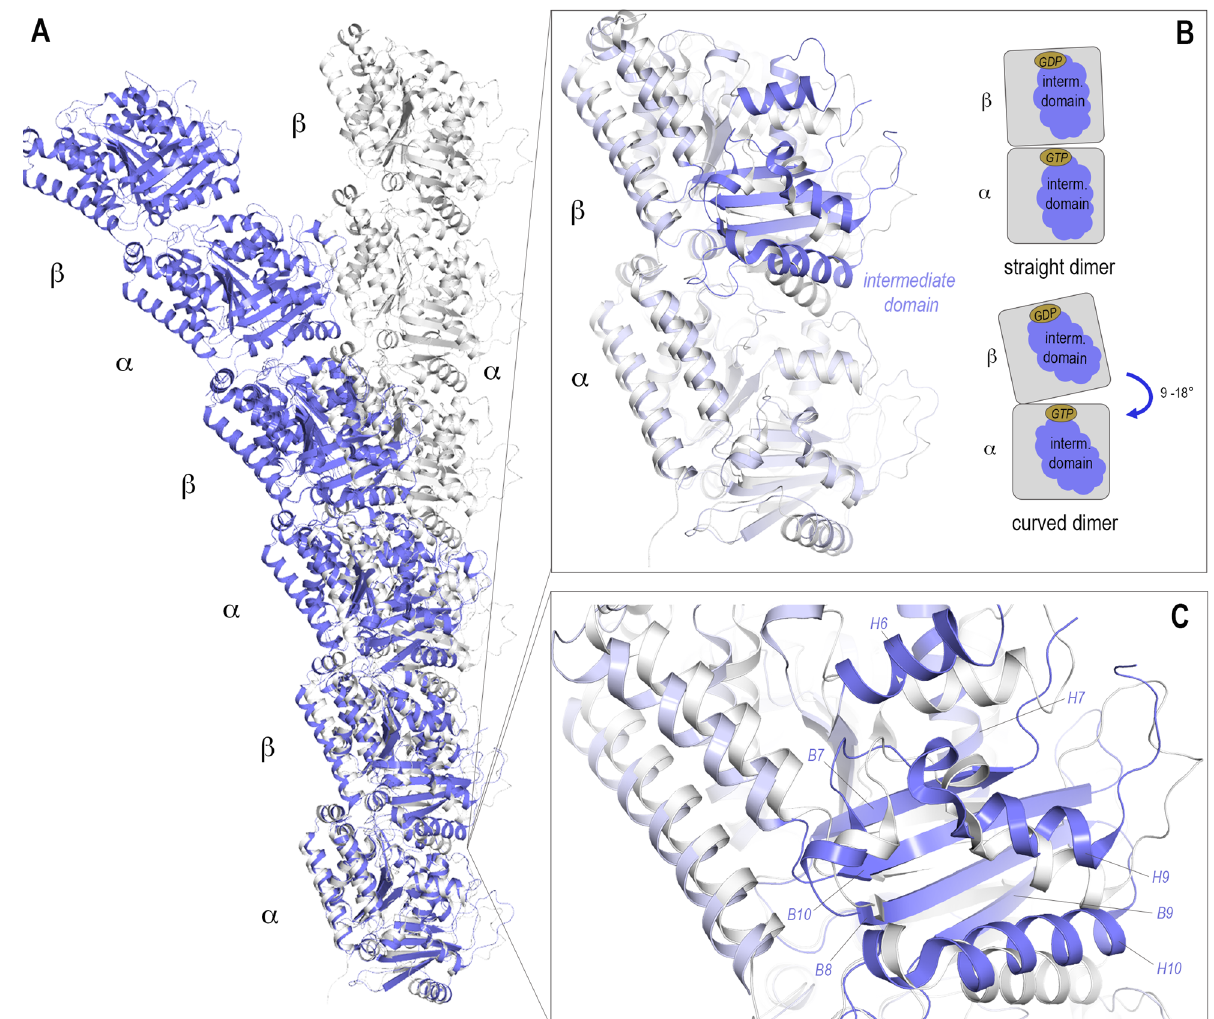
Figure 2. The “curved” and “straight” tubulin conformations. ( A ) A straight protofilament, as present in the MT lattice, is shown in ribbon presentation in light gray (PDB ID 7SJ7). A protofilament constituted of tubulin in a curved conformation is shown in blue (from PDB ID 5LXT). ( B ) The intrinsic curvature and structural differences on a single dimer are shown: A heterodimer in the straight conformation is depicted in light gray and the curved conformation in light blue. The main differences in the structures are within the intermediate domain (residues 206–384), highlighted in darker blue, which upon curved-to-straight transition moves relative to the other domains. This is also indicated in the schematic drawing of both straight and curved dimers. The angle corresponds to the relative curvature of one monomer to the other. ( C ) The structural elements of the intermediate domain are shown in more detail, the changes necessary for “straightening” are mainly translation of the shown H7 as well as rotation of the neighboring structural elements H6-10 and